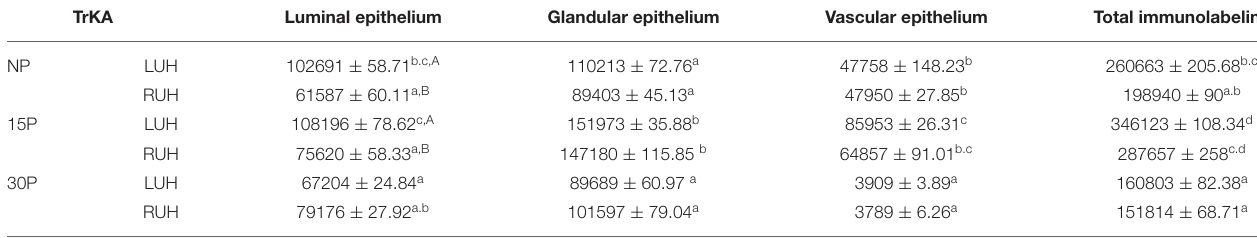
TABLE 3 | Densitometry analysis of TrKA immunolabeling in alpaca endometria.